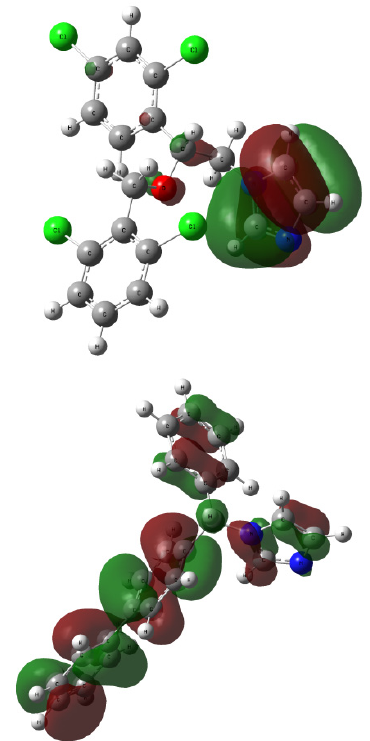
Figure 9. The LUMO orbitals generated for compound 1 ( up ; rotamer optimized at the B3LYP/6-31G(d,p) level of theory in methanol) and 2 ( down ; rotamer optimized at the wB97XD/6-31G(d,p) level of theory in methanol); vertical excited states calculated at the functional/6-311++G(2d,3p) level of theory (functional: B3LYP or wB97XD for 1 or 2 , respectively).